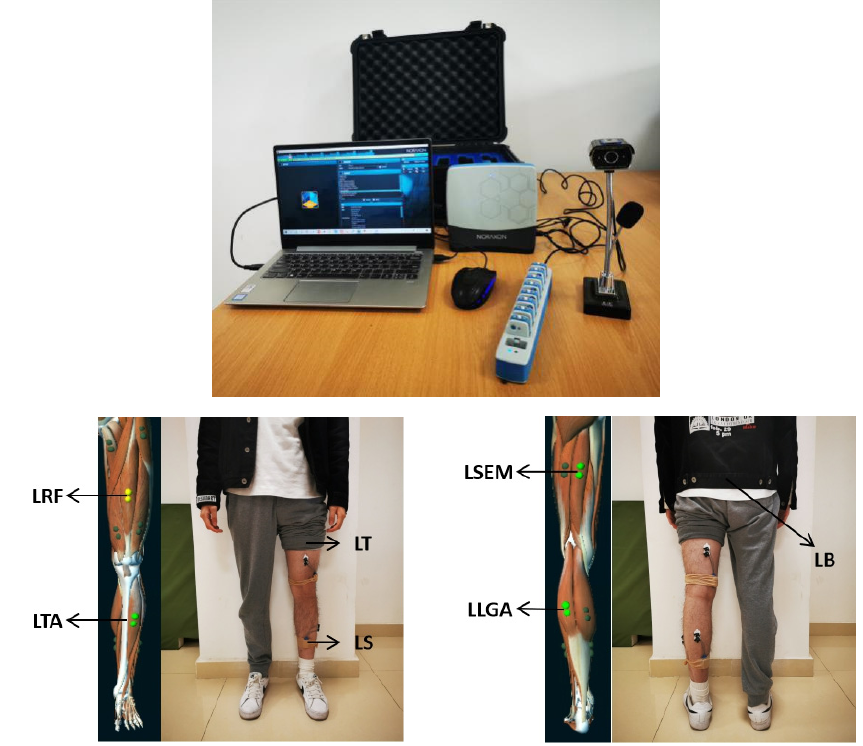
Figure 6. Experiment system and the arrangement of sensors. Sensor data was sent via Bluetooth to the NORAXON Ultium Receiver, which was connected to a laptop via USB3.0 and synchronized with a 720P webcam for recording video. Raw data was collected and marked using the myoRESEARCH 3.12 (Noraxon USA). Two assistants who were not involved in the experiment were recruited, one marked the participants’ activities according to the synchronized video recording, the other checked the marked video and discussed with the first in case of disagreement. 3.3. Preprocessing and Segmentation